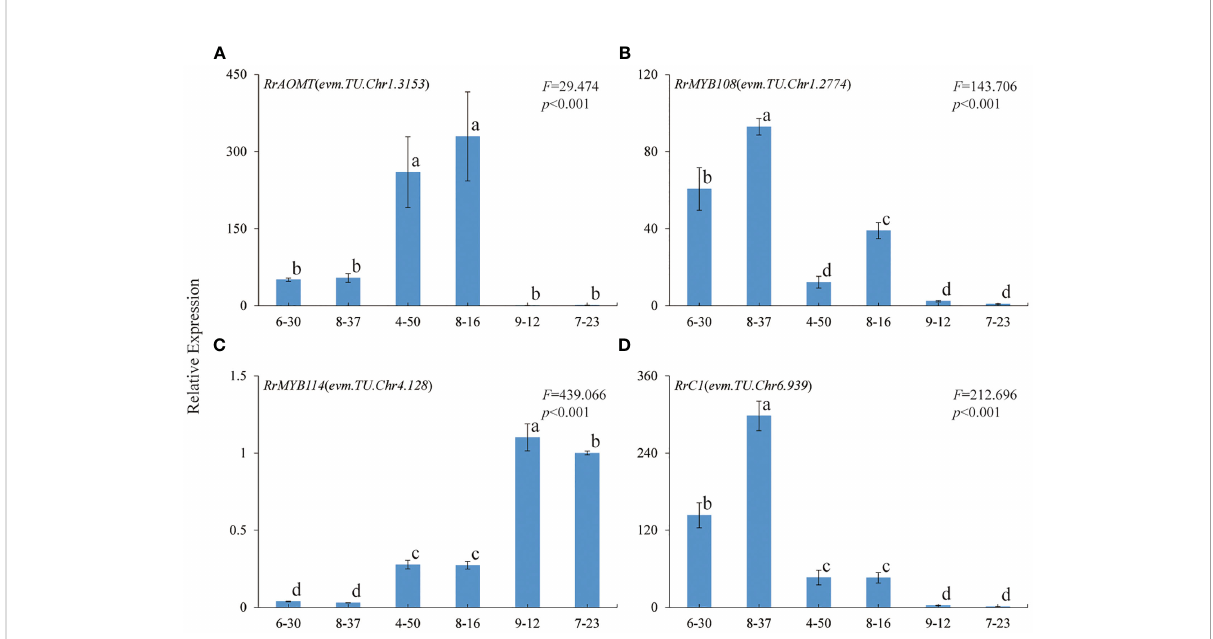
FIGURE 7 Expression patterns of four key genes in six R. rugosa germplasms. (A) RrAOMT. (B) RrMYB108. (C) RrMYB114. (D) RrC1. The different small letters indicate signi fi cant difference between germplasms at a